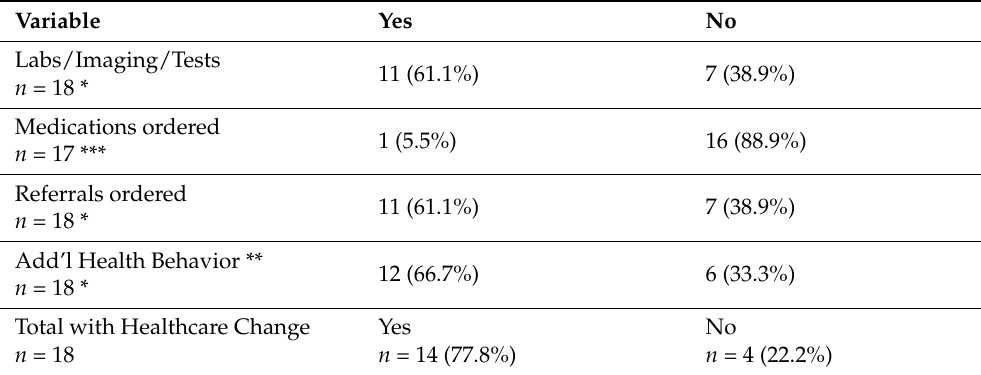
Table 3. Six-month